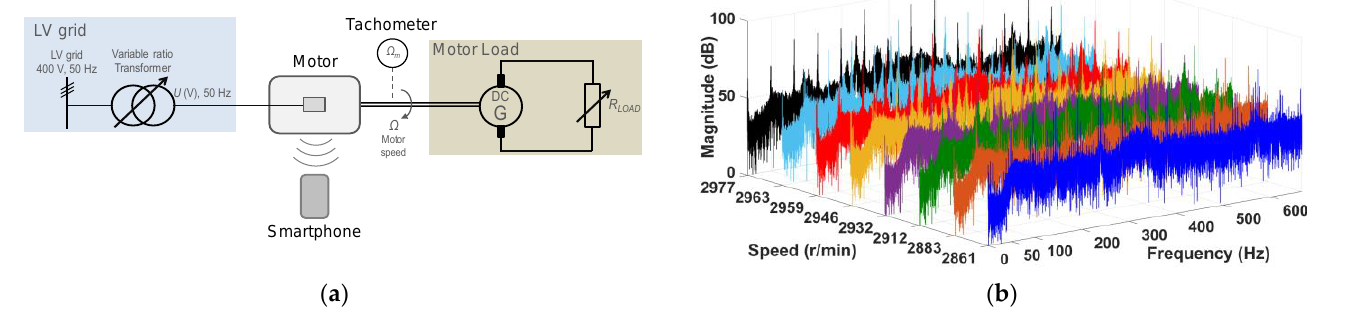
Figure 7. DC generator coupled to the motor shaft: ( a ) the test configuration; ( b ) the spectra of the motor noise signals.